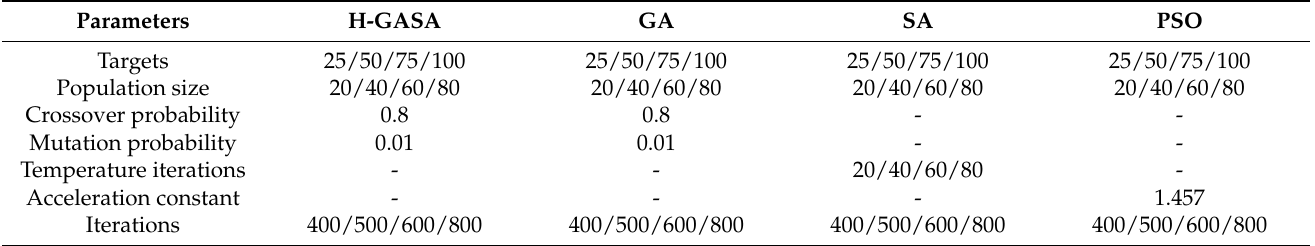
Table 5. The parameters of all algorithms for different scenarios.